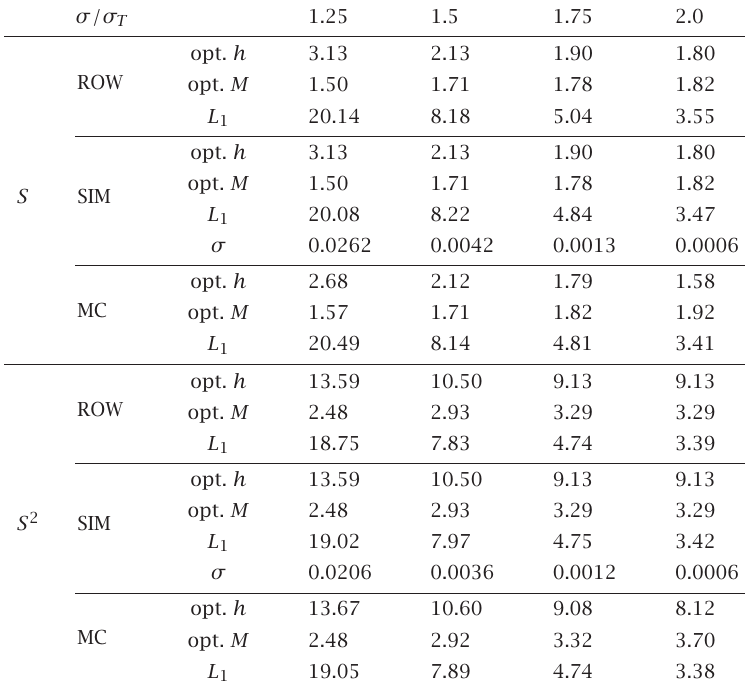
Table 1.2 . Comparisons of the ARL profile of Cusum using Rowlands’ method (ROW), Markov chain approach (MC), and simulation (SIM) for sam- ple size n = 3. The control statistics S and S 2 are used. The in control ARL is